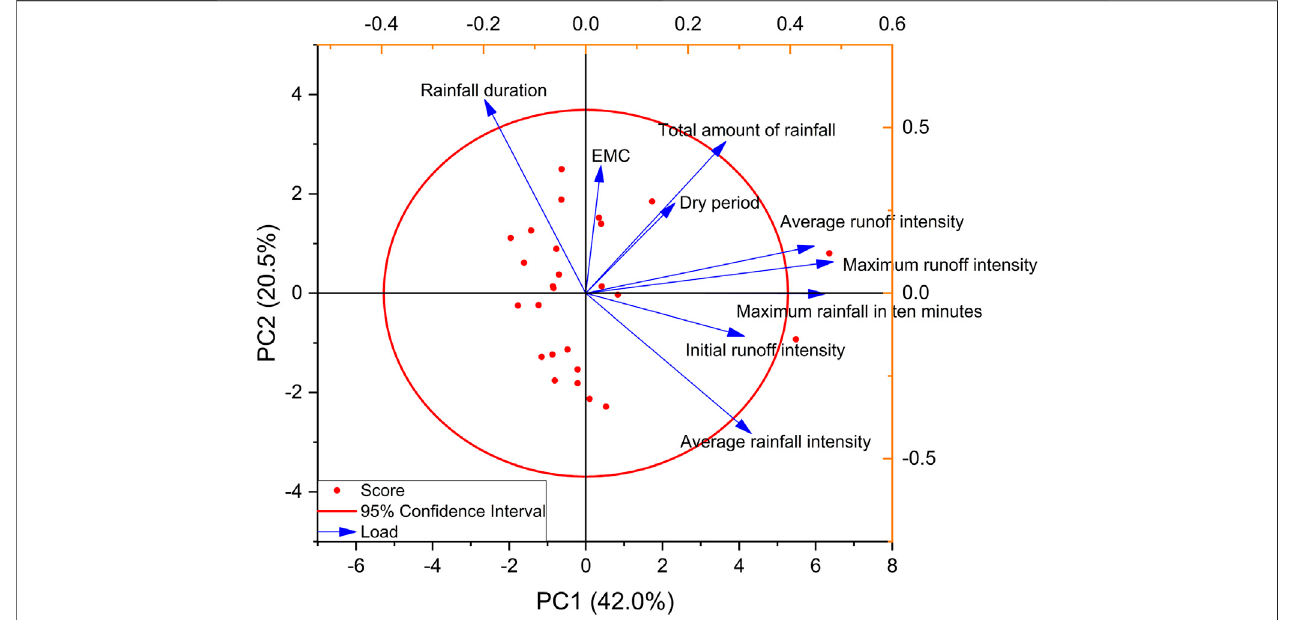
FIGURE4| PCAresultsbetweenrainfallcharacteristicsandEMC.PC1andPC2represent 42%and20.5%ofthetotalvarianceofthedata,respectively.Reddots represent the scores of rainfall events. The red circle represents the 95% con fi dence interval. The blue arrows represent the proportions contributed by rainfall characteristics to PC1 and PC2.